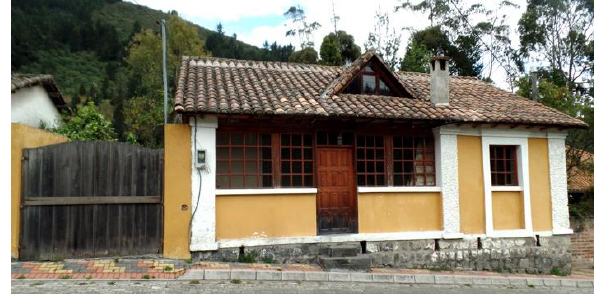
Figure 5. Continuous Opening type House, Nono, Ecuador,